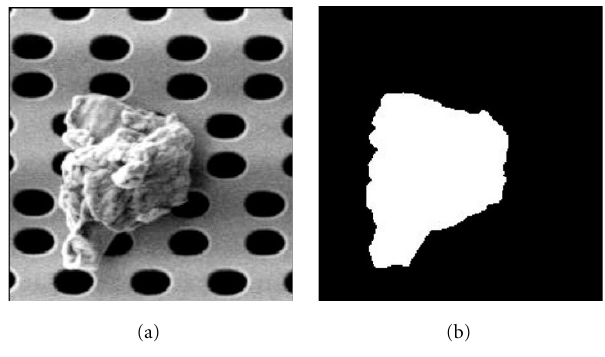
Figure 2: (a) SEM image of a particle defect. (b) Associated defect mask generated by the inspection tool during automatic redetec-